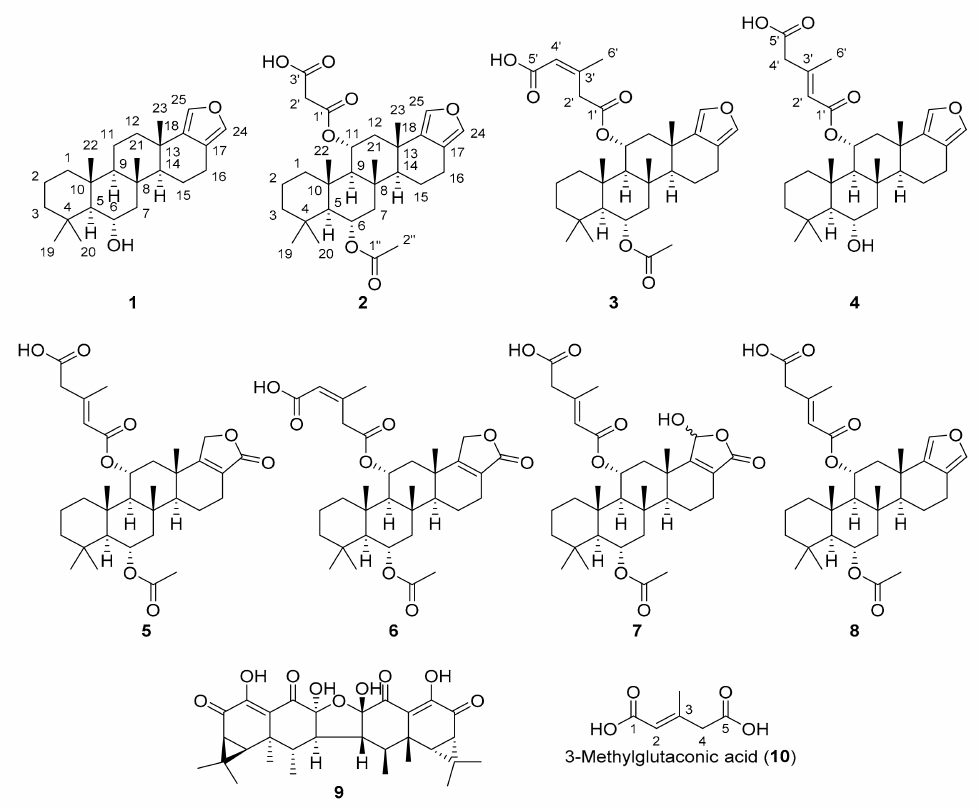
Figure 1. Structures of the isolated compounds from N. nambi ( 1 – 9 ) and 3-methylglutaconic acid ( 10